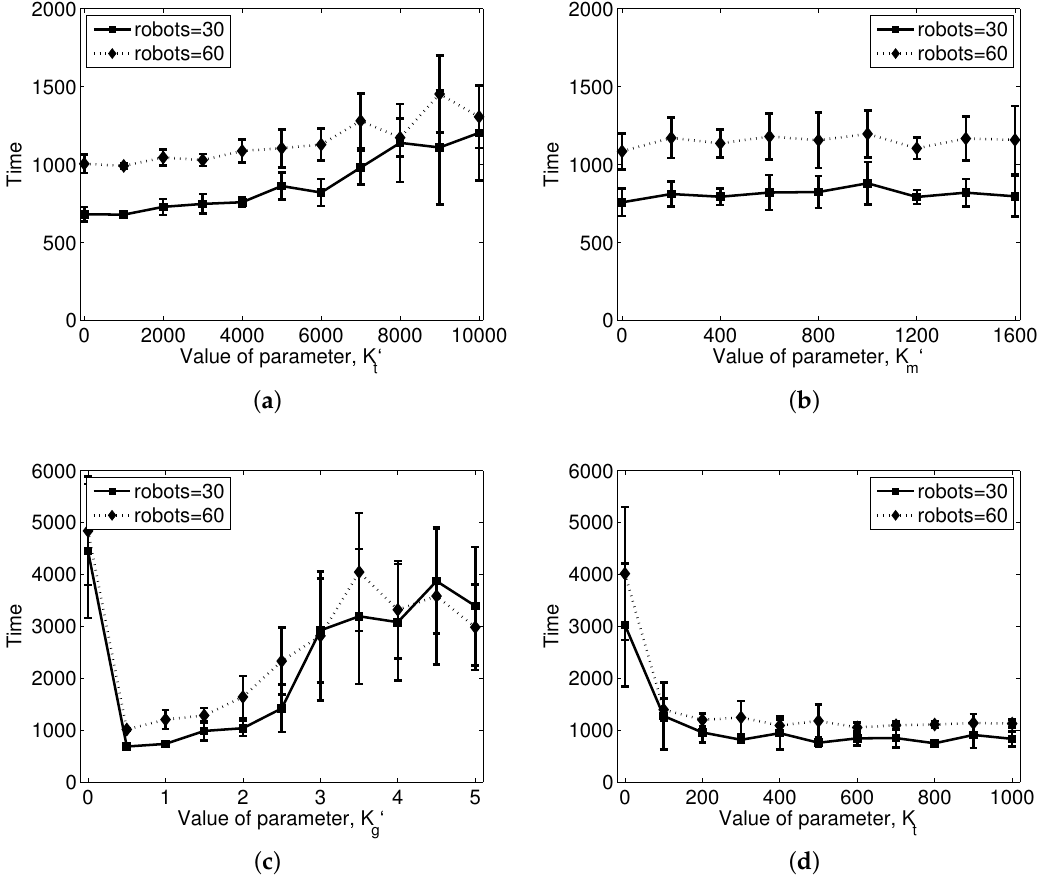
Figure 11. Time needed to reach the goal area with changes in parameters for the shepherding task: ( a ) K (cid:48) t controls the collision avoidance of the steering agents from the flock; ( b ) K (cid:48) m controls the collision avoidance among the steering agents; ( c ) K (cid:48) g drives the flock to the goal area; and ( d ) K t causes the sheep agents to move away from the steering agents; ( a – c ) are for the steering agents, and ( d ) is for the sheep